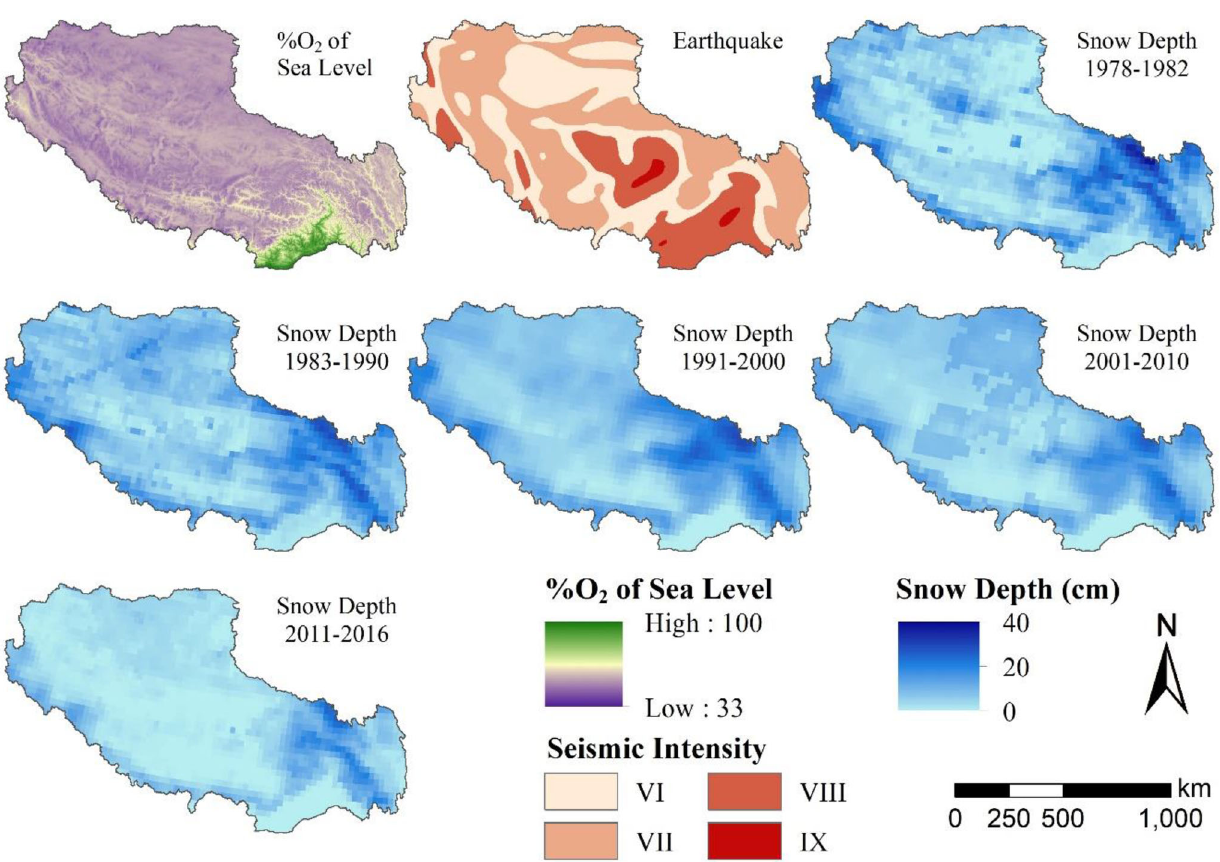
Fig. 1 Intensity of hypoxia, earthquakes, and snowstorms in